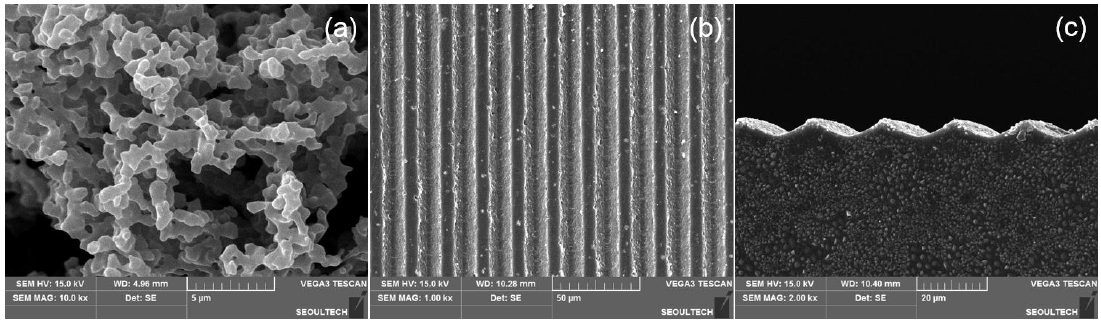
Figure 4. SEM images of ( a ) HA powder, ( b ) surface of HA-BDDGE patterned gel, and ( c ) cross-section of HA-BDDGE patterned gel.